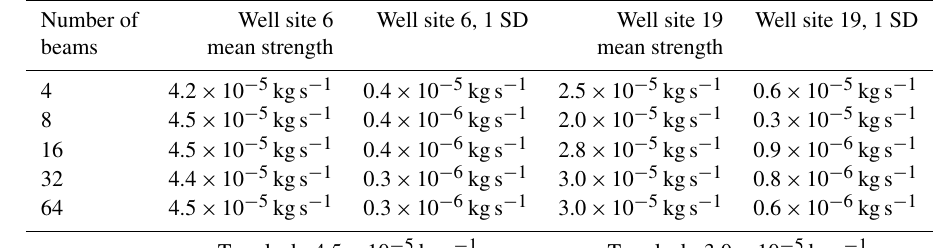
Table 1. NZMB solutions for leak strength of true leaks, given 2ppb model–data mismatch uncertainty, for each beam configuration.